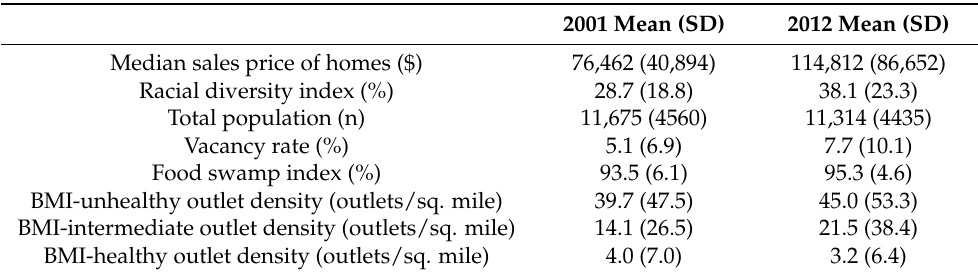
Table 1. Summary statistics of key variables for community statistical areas (CSAs) (n = 55) in Baltimore, MD, in 2001 and